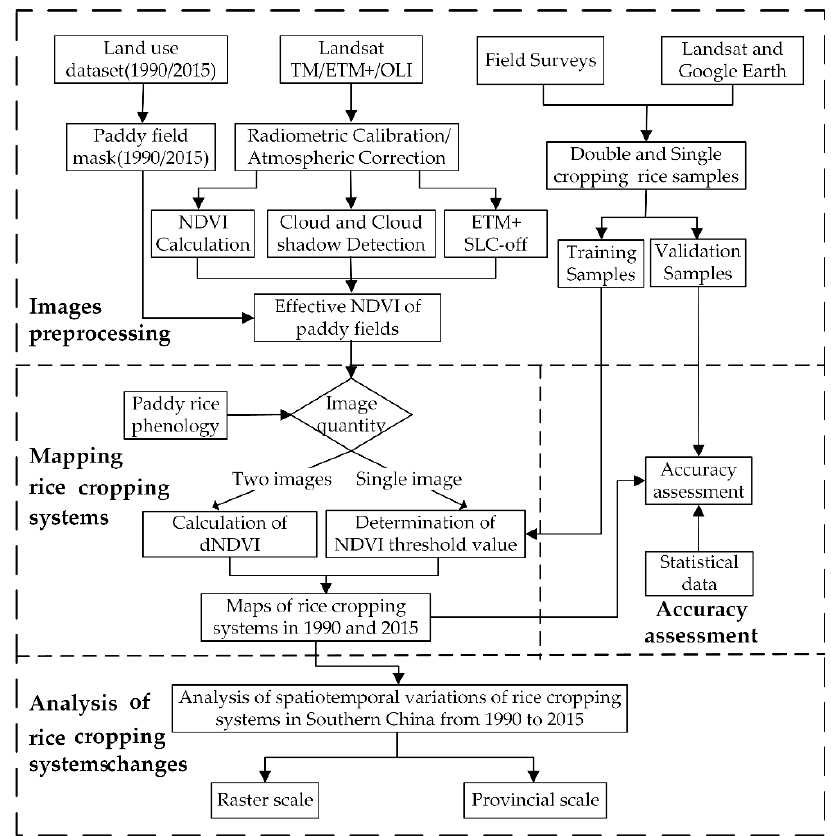
Figure 3. Overview of methodology. The dNDVI donates differences of Normal Difference Vegetation Index (NDVI), and statistical data refers to provincial statistical data of rice sown areas.